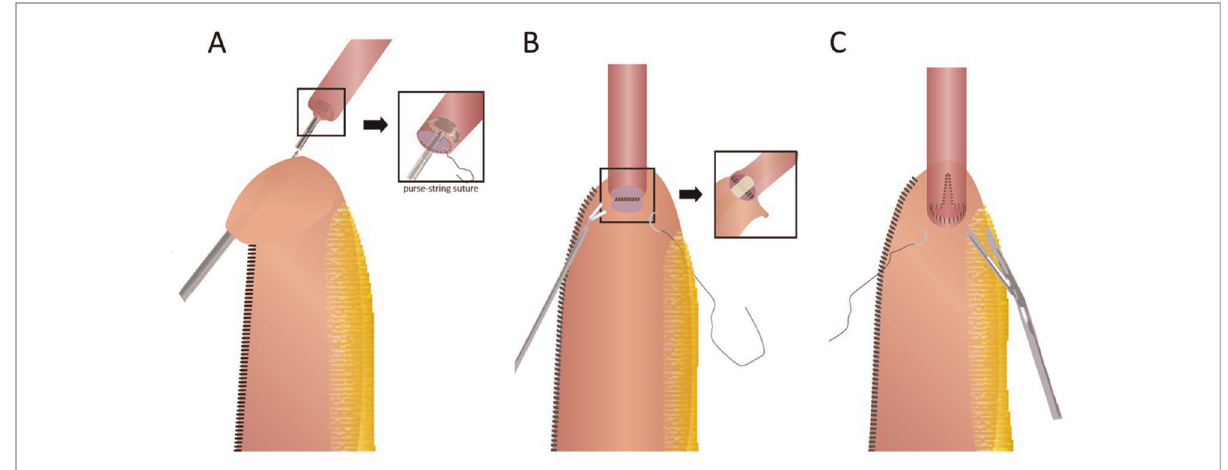
FIGURE 3 Three types of robot-assisted intrathoracic esophagogastric anastomosis. ( A ) Circular stapling technique; ( B ) fully robotic hand-sewn technique; ( C ) linear stapling technique with robotic hand-sewn closure of the stapler